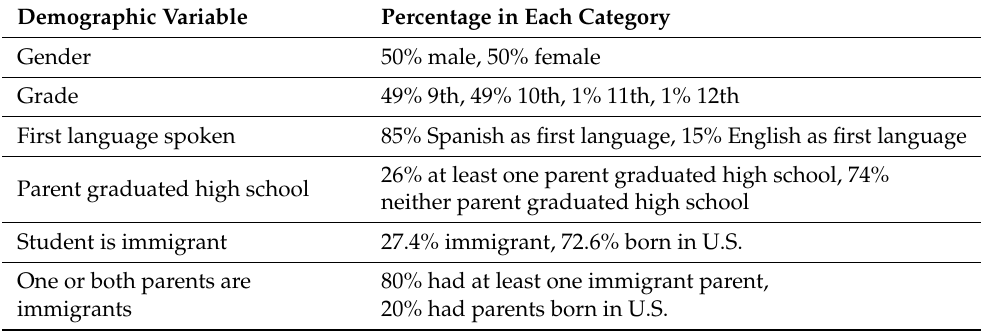
Table 1. Summary of participant demographic